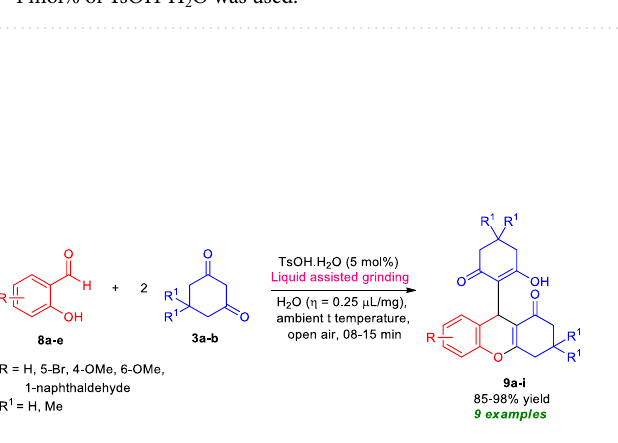
Figure 9. Synthesis of tetrahydro-1 H -xanthen-1-one under the standard